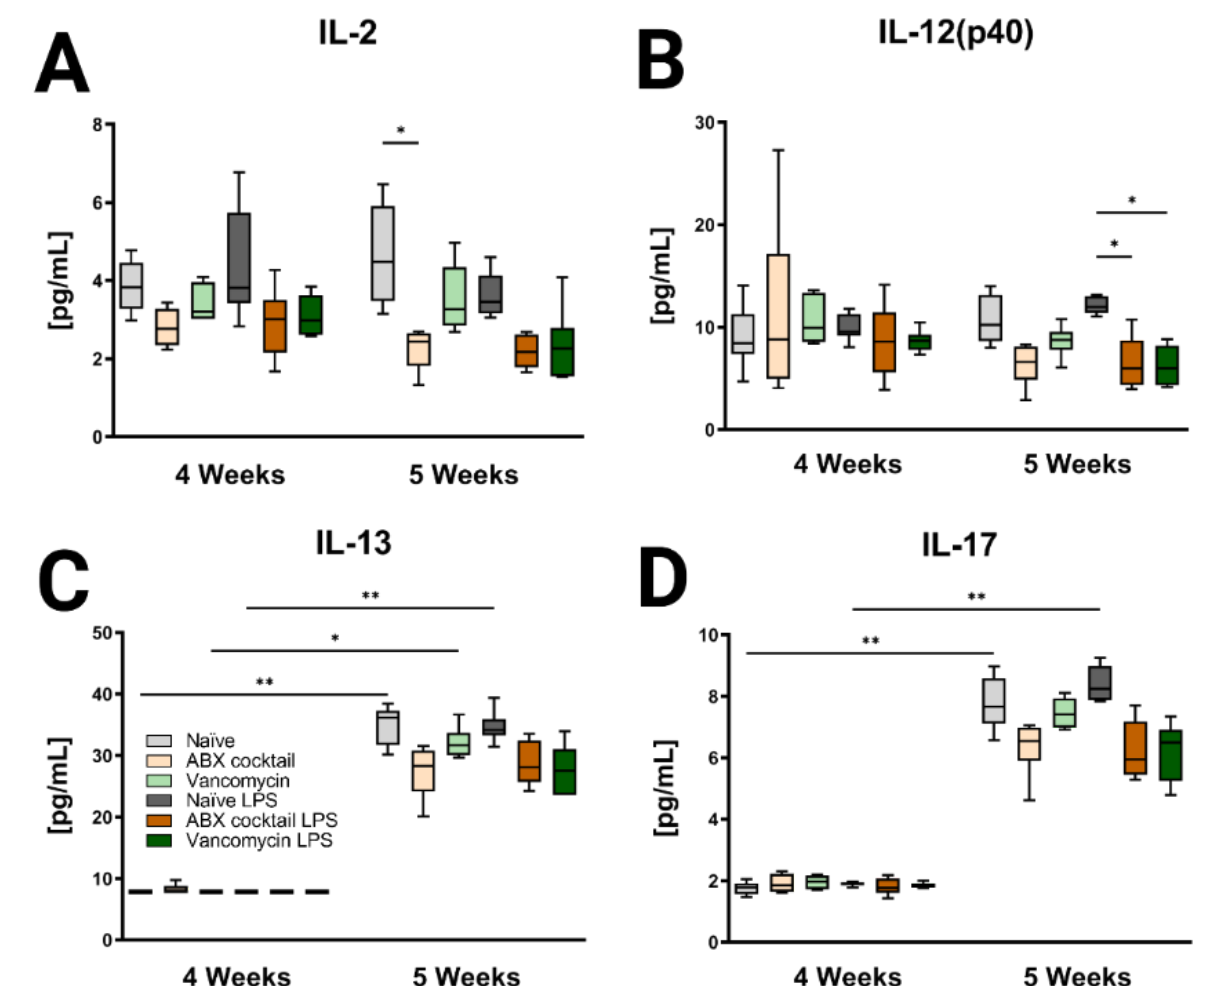
Figure 6. Inducible brain cytokines are affected by maternal ABX treatment. Data showing the responses of ( A ) IL-2, ( B ) IL-12(p40), ( C ) IL-13, and ( D ) IL-17 at 4 and 5 weeks. Naïve = light grey, ABX cocktail = light brown, Vancomycin = light green, Naïve LPS = grey, ABX cocktail LPS = brown and Vancomycin LPS = green. n = 6 for all groups. Kruskal–Wallis with Dunn’s multiple comparison test. Values represent median + interquartile range means ± SEM, * p ≤ 0.05, ** p ≤ 0.01.